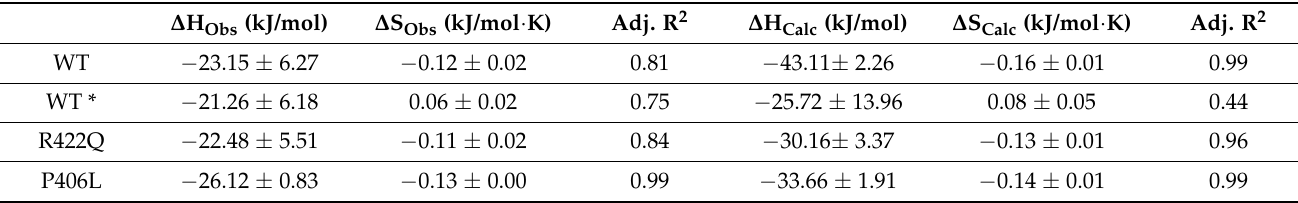
Figure 5. The apparent thermodynamic signatures of the diphenol oxidase reactions suggest reactions driven by enthalpy and entropy forces. WT, R422Q, and P406L are shown in blue, orange, and gray, respectively. All experiments were performed in duplicates and error bars represent standard deviations. The thermodynamic signatures for the docking simulations are shown in the Supplementary Materials Figure S3. Table 2 features the apparent ∆ H and ∆ S. Table 2. Enthalpy and entropy of WT, R422Q, and P406L obtained from Van’t Hoff analysis of the diphenol oxidase reactions and computational simulations.